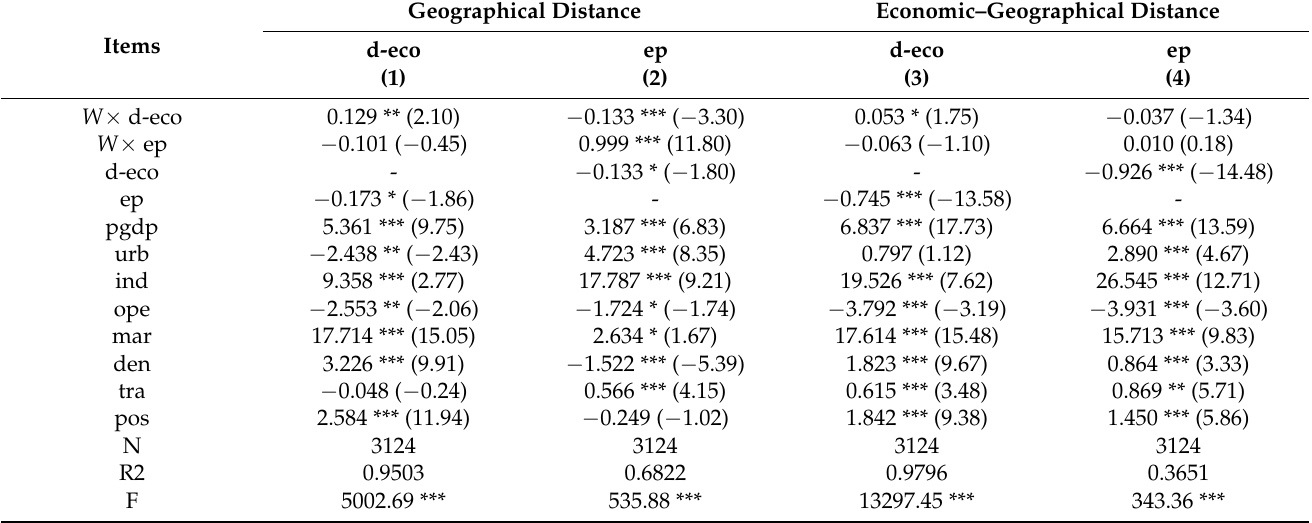
Table 4. Global estimation results of